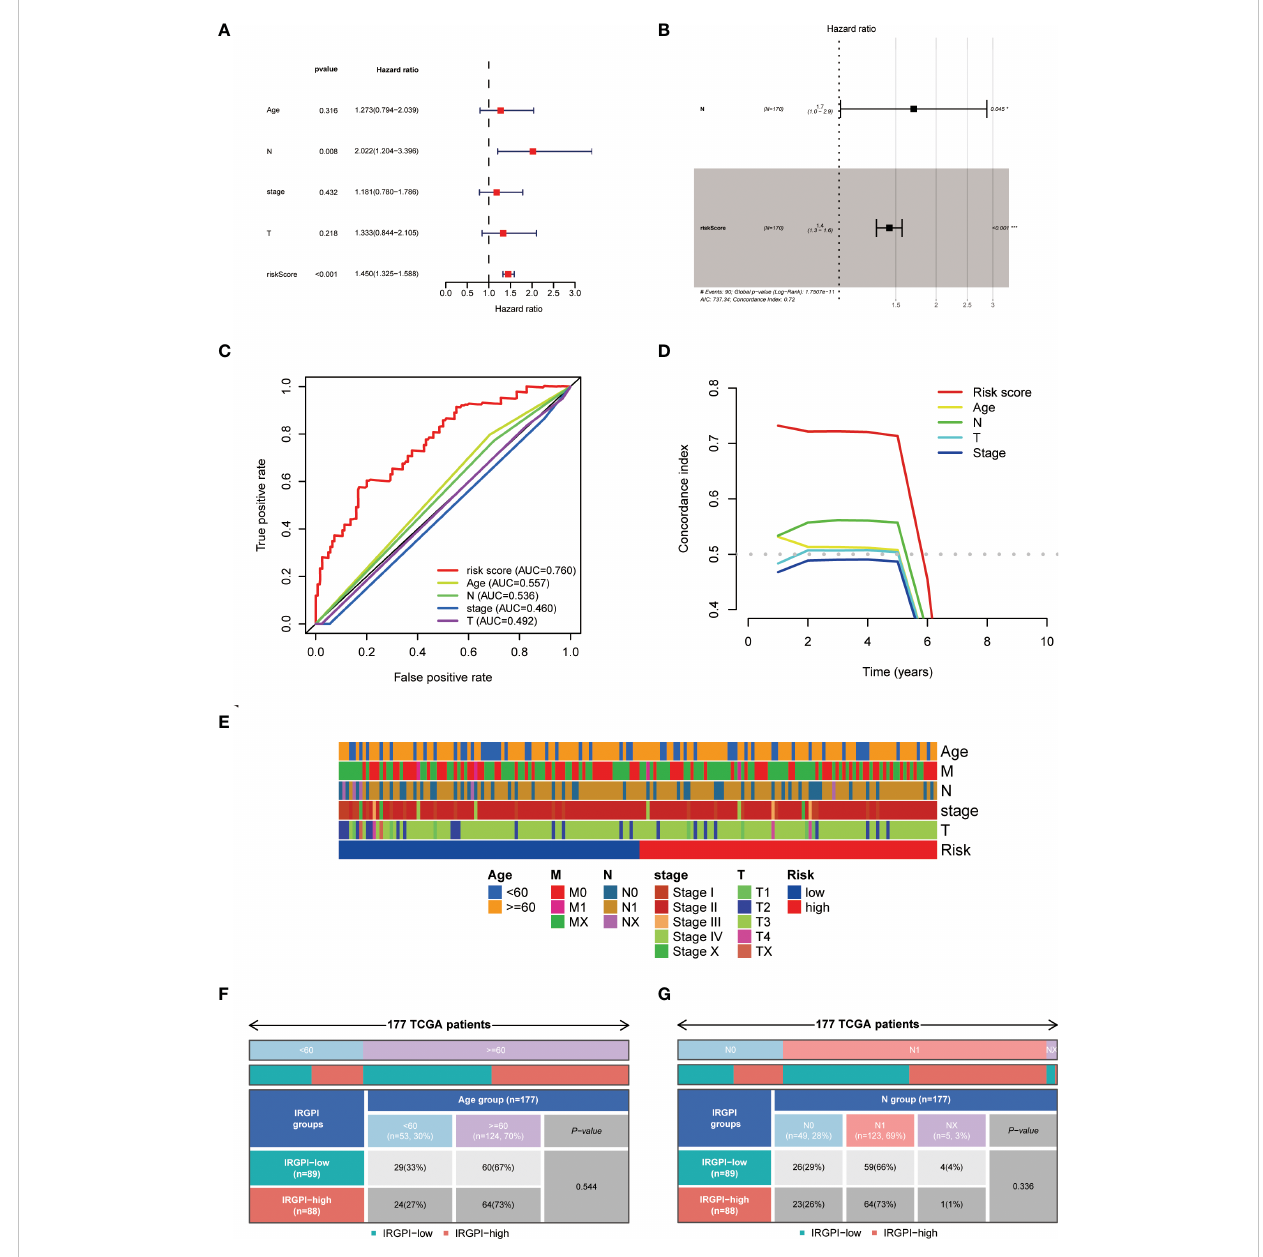
FIGURE 7 Relationship between HAPM and clinical characteristics. (A, B) univariate Cox and multivariate Cox analyses of the risk score and clinical characteristics. (C, D) Comparison of prognostic ef fi cacy of the risk score with clinical characteristics by ROC curves and C-indices. (E) Distribution of clinical characteristics across different subgroups. (F, G) Differences in age and N-stage in different